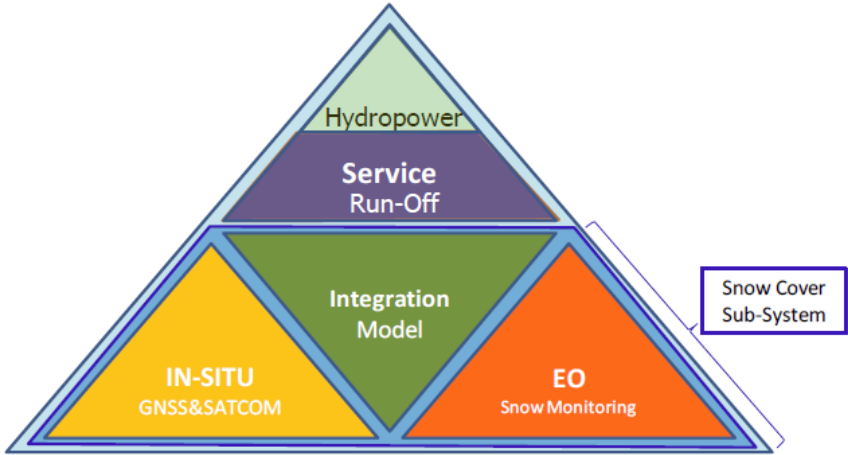
Figure 1. The modular concept of SnowSense, integrating satellite technologies like Global Navigation Satellite System (GNSS), satellite communication and Earth Observation (EO) as the basis for a